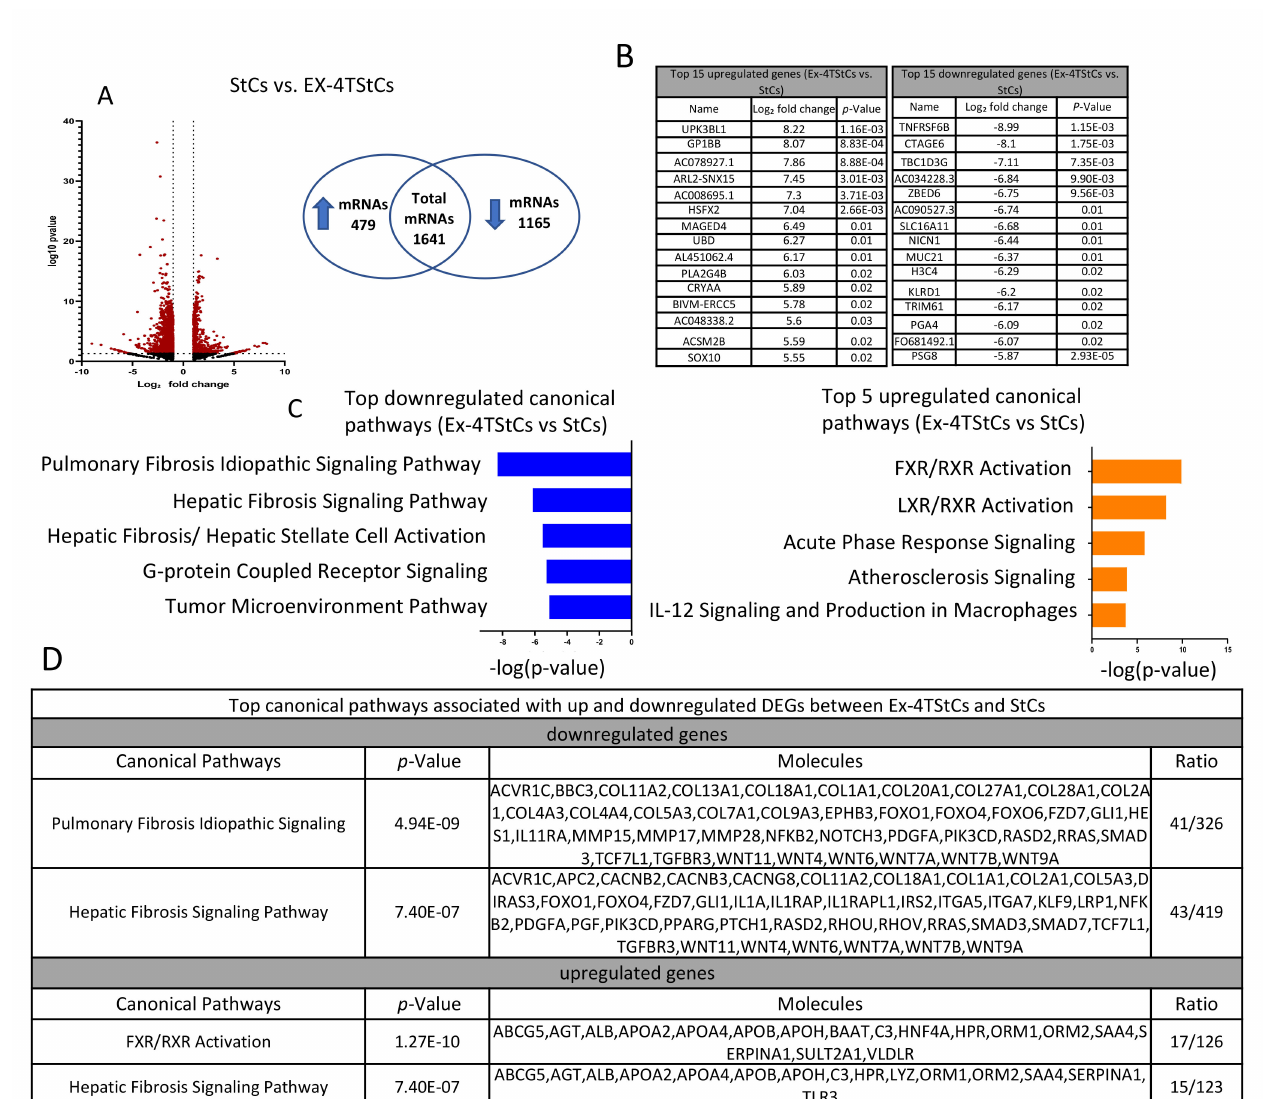
Figure 4. Transcriptome analysis of Ex-4TSC versus SC. ( A ) 1644 mRNAs were determined to be statis- tically differentially expressed (red dots: >2-fold difference, p < 0.05), of which 479 were significantly upregulated and 1165 significantly downregulated. ( B ) Top 15 individual up- and downregulated DEGs between Ex-4TSC and UC. ( C ) Top 5 up- and downregulated canonical pathways identified by IPA. ( D ) Top 2 canonical pathways identified by IPA using up- or downregulated genes and the number of molecules involved. The Venn diagram’s upward and downward arrows indicate upregulation and downregulation, respectively. The ratio indicates the number of genes in the analyzed data over the number of genes known to be involved in the